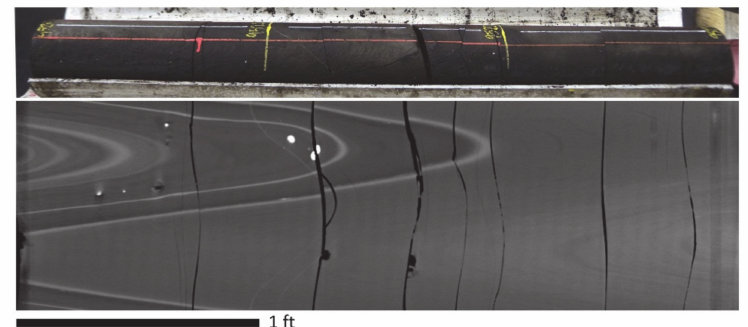
Figure 5. Tightly-spaced hydraulic fractures observed at the HFTS. Top: 3-ft long core-back sample containing eight parallel/sub-parallel hydraulic fractures. Bottom: CT scan image of the correspond- ing core sample. More details may be found in